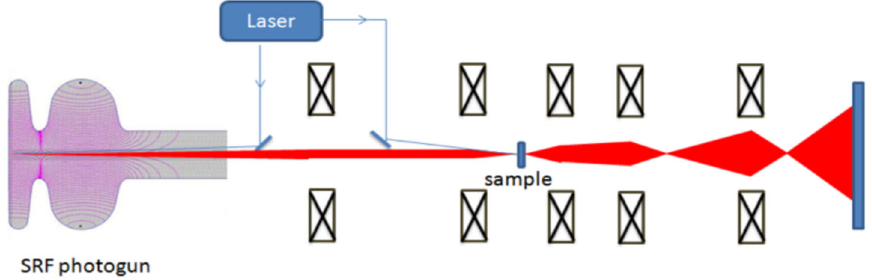
Figure 1. Schematic layout of the Euclid SRF photogun-based UEM system [14].